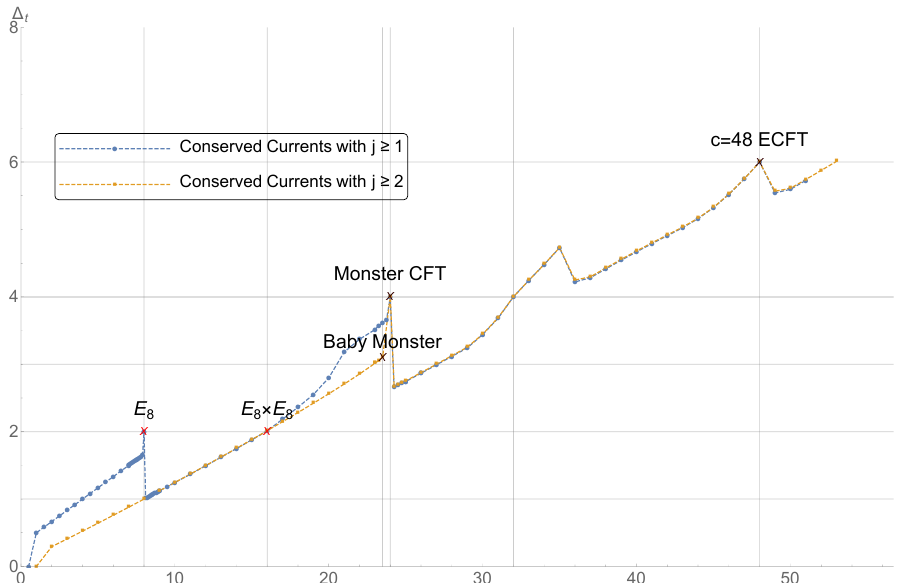
Figure 2. Numerical bound for the twist gap, in the presence of the conserved currents of spin 1 (cid:20) j (cid:20) j max and the conserved currents of spin 2 (cid:20) j (cid:20) j max